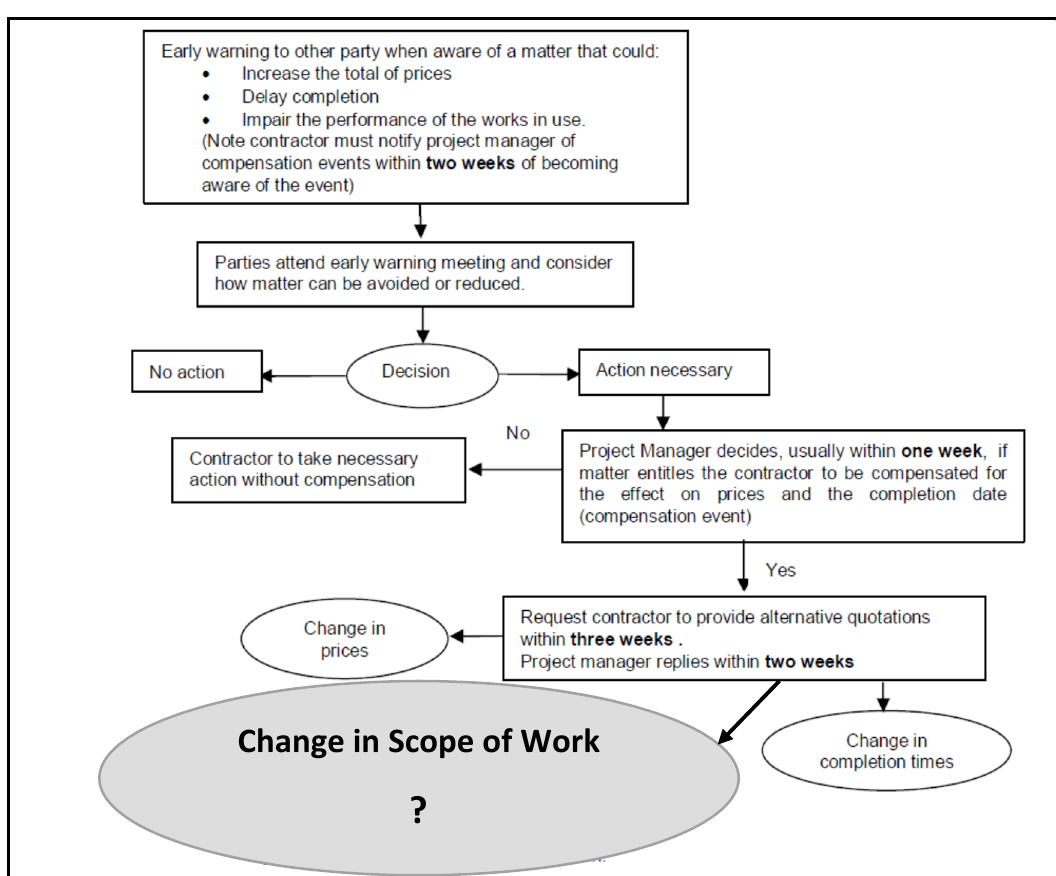
Figure 2. Change control system in the